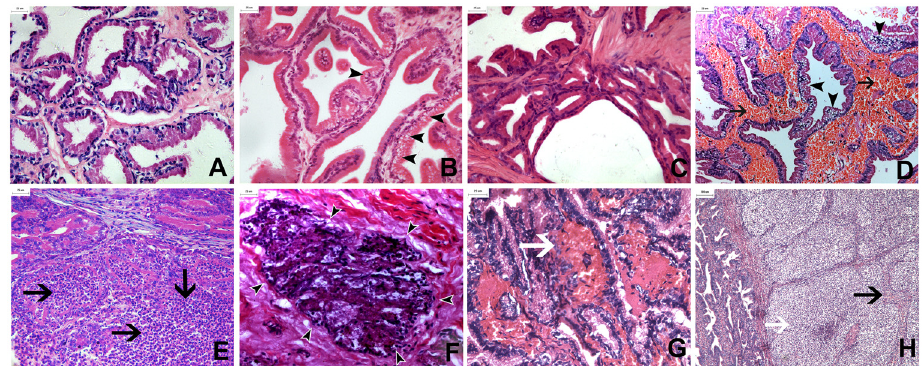
Fig 5. Prostate samples harvested from different groups after treatment (scale bar = 25 μ m in A-G and 100 μ m in H). (A) Normal histological structures displayed in the MB group. (B) Vacuolization of epithelial cells [arrowhead] was displayed in the US group immediately after ultrasound irradiation. (C) Almost complete recovery of the affected cells 48 hours later in the US group. (D-F) Microscopic examination results after microbubble-enhanced ultrasound (MEUS) treatment (D: Vacuolization of epithelial cells [arrowhead], red blood cells filling the stroma [arrow], diffuse thrombosis, enlarging and squeezing of the stroma immediately after MEUS; E: Areas of diffuse neutrophil infiltration [arrow] were observed frequently in the stroma and glandular lumen 48 hours after treatment; F: Collapse of glandular structure [arrowhead] and focal necrosis with pyknosis 4 days after treatment). (G, H) Microscopic examination results after microbubble-enhanced ultrasound and prothrombin (PMEUS) treatment (G: More severe hemorrhage and thrombosis than the MEUS group in the interstitial tissues immediately after PMEUS [white arrow]; H: Significant squeezing and focal necrosis of prostatic tissues [black arrow] by the compression of neutrophil infiltration 48 hours after treatment [white